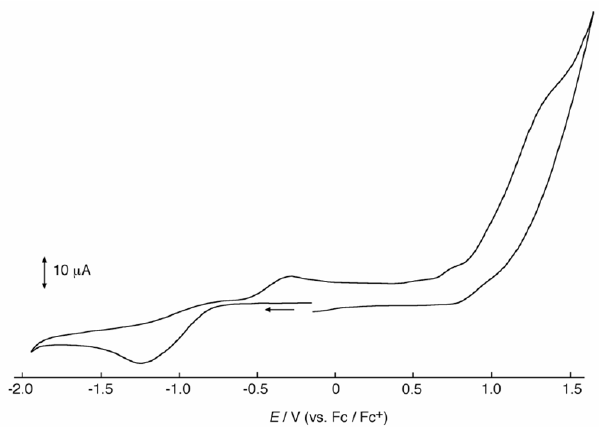
Figure 9. Cyclic voltammograms of [Co 3 (Hclsalpr) 2 (CH 3 COO) 4 ] in THF ([complex] = 1 × 10 –3 M; [TBAP] = 0.2 M; scan rate = 100 mV s –1